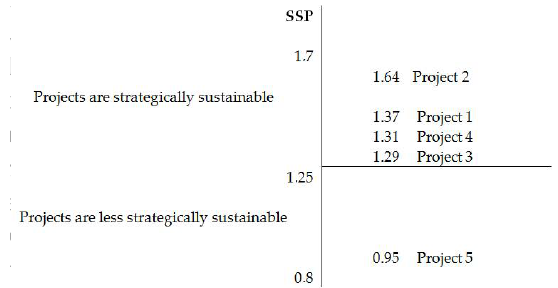
Figure 2. Interpretation of the calculation of the strategic stability of the Company’s o ff shore projects. Source: authors